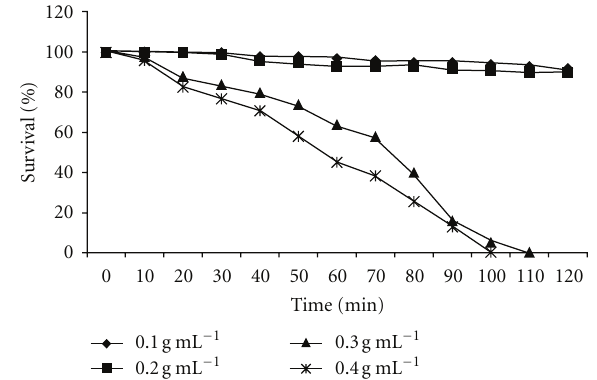
Figure 3: Antitermitic activity of acetone extracts of P. biglobosa